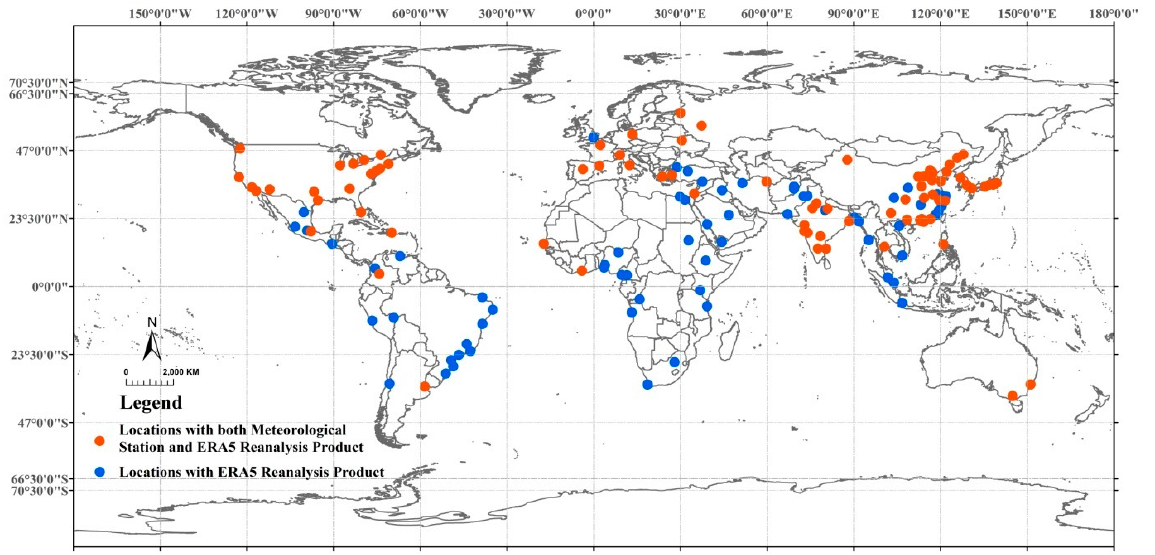
Figure 1. Global distribution of the 150 most populated metropolitan locations .